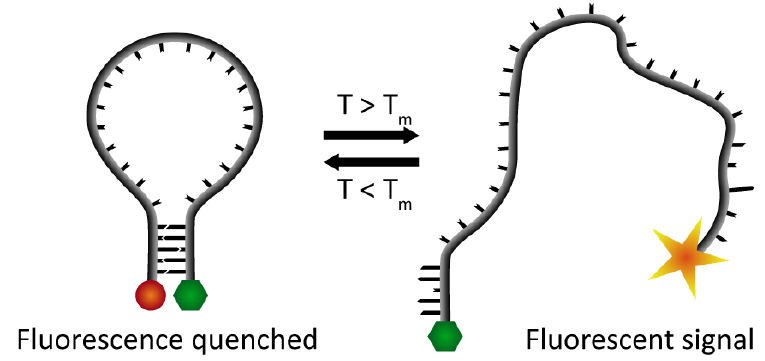
Figure 1. Schematic illustration of a DNA hairpin end-labeled with a donor-acceptor pair of dyes. When the DNA is in hairpin conformation, the acceptor (green) quenches the light emitted from the donor (red). Upon melting of the hairpin, the dyes are separated, and light emitted from the donor can be detected.